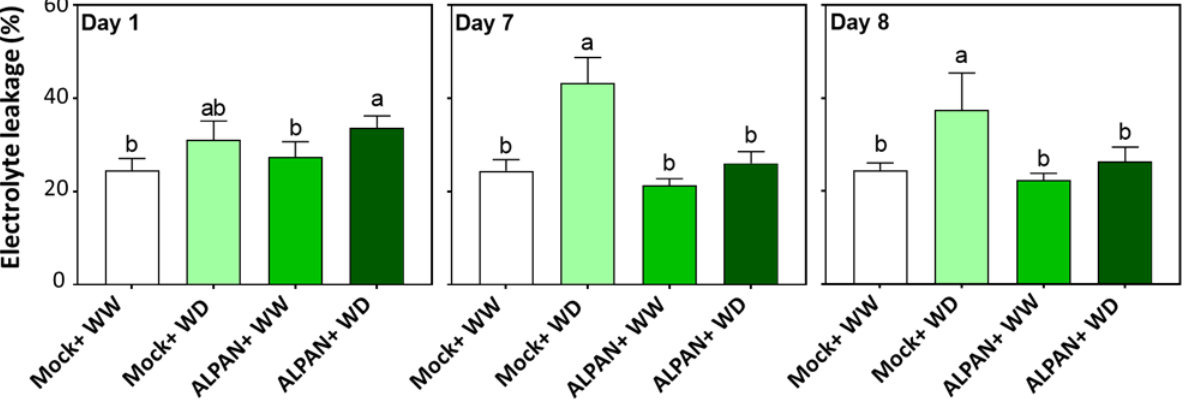
Figure 2. Electrolyte leakage determined after 1, 7, and 8 days of the initiation of the water deficit stress. WW = well watered, WD = water deficit. Error bars above histogram columns represent the standard deviation of four independent biological replicates in each experimental group at each sampling timepoint. The statistical data were analyzed with the use of the one-way ANOVA and Tukey’s post hoc tests, and a statistically significant difference ( p -value < 0.05) is denoted by a different letter above a histogram column.